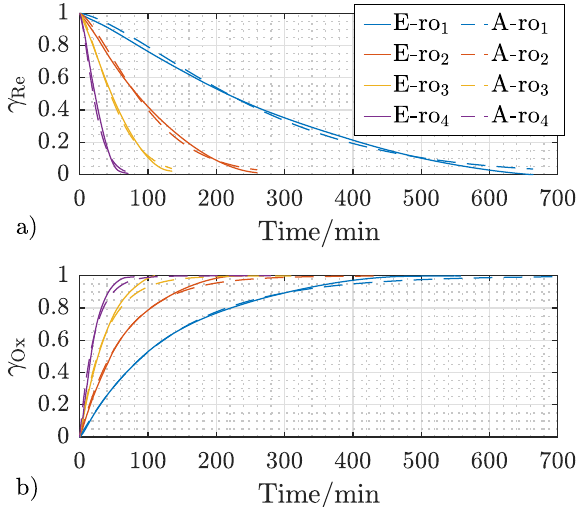
Figure 6. Experimental (E-) and analytical (A-) reaction behavior of S1 at 700°C and 250mL/min for the gas concentrations ro 1 to ro 4 (cf. Table 2) for reduction ( a ) and oxidation ( b